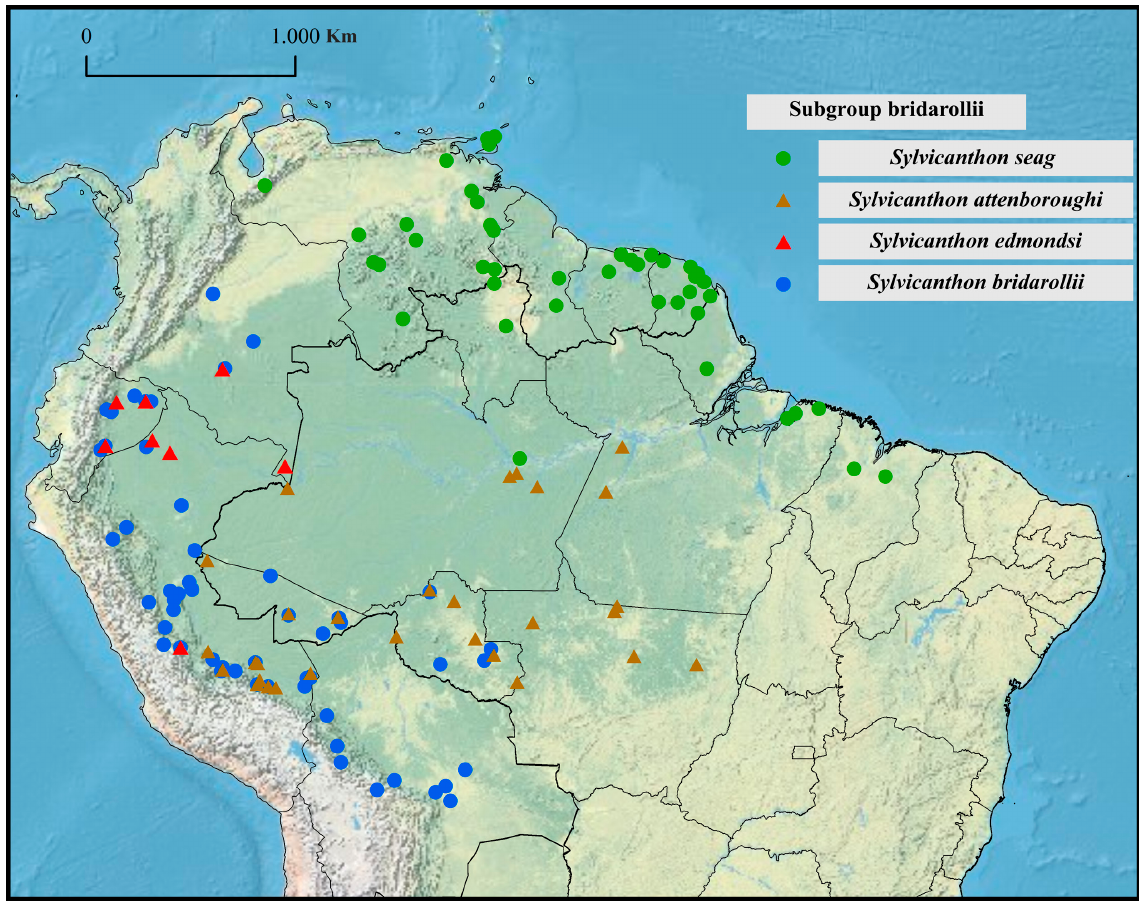
Fig. 34. Distribution of the four species of the bridarollii